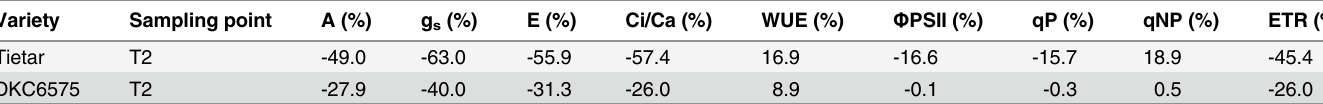
Table 2. Percentage variation in the drought stress treatment (irrigation 0% of fi eld capacity) with respect to the control (irrigation 0% of fi eld capacity) for selected photosynthesis (A = net photosynthesis; g s = stomatal conductance to water vapour; E = leaf transpiration; Ci/Ca = ratio between stomatal and ambient CO 2 concentration; WUE = Water Use Ef fi ciency), and fl uorescence parameters ( Φ PSII = effective quantum ef fi ciency of PSII; qP = photochemical quenching; qNP = non photochemical quenching; ETR = electron transport rate; F v /F m = maximum quantum yield of PSII), measured on Tietar and DKC6575 at T2 (after 20 d without irrigation) in the fi eld experiment.